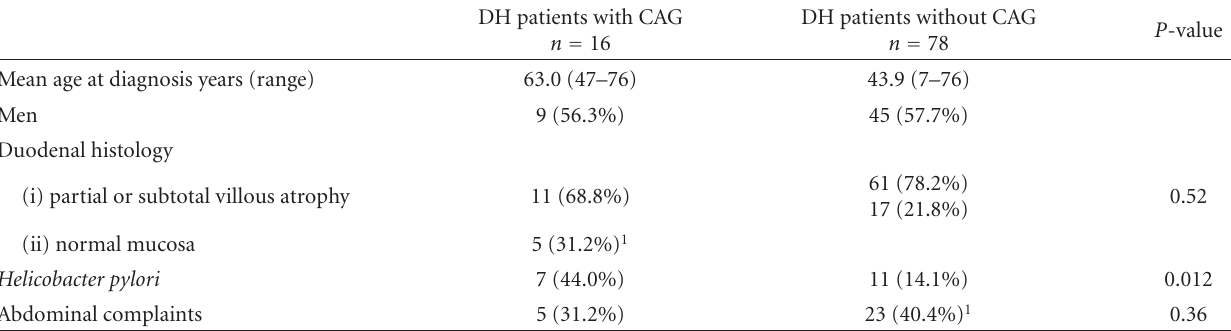
Table 3: Data on 94 patients with dermatitis herpetiformis. Comparison between cases with and without chronic atrophic gastritis